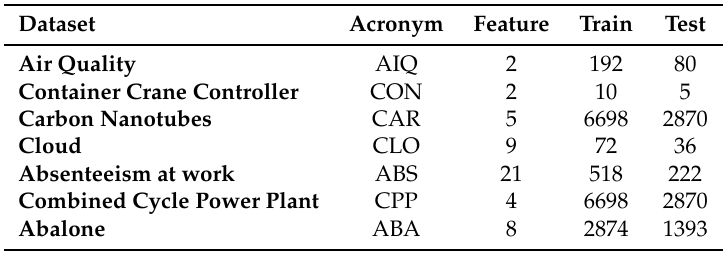
Table 11. Data sets used in the experiments for regression problems.